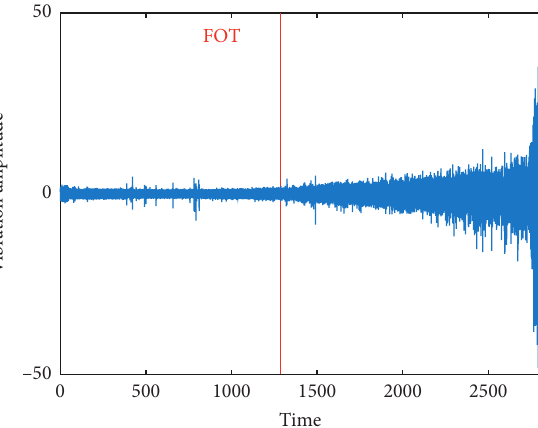
Figure 5: The FOT determined by the applied